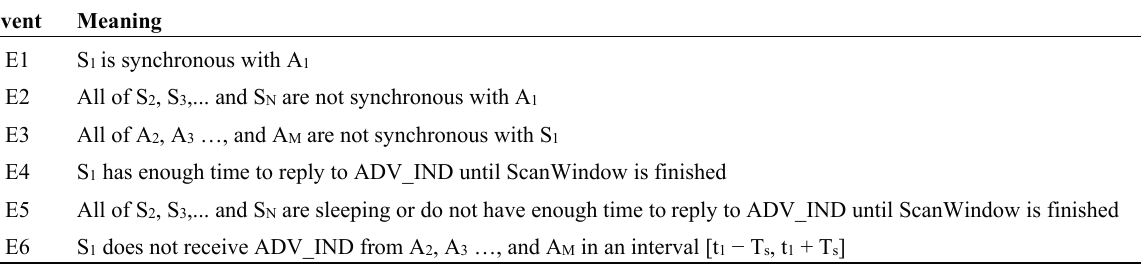
Table 2. Events used for analysis of the device discovery process.